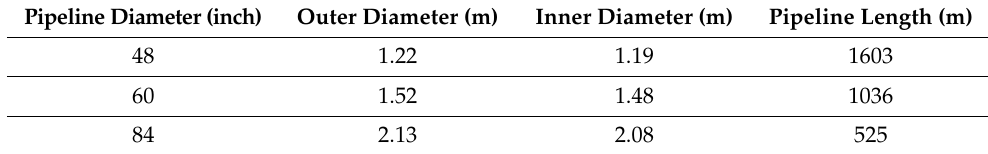
Table 3. Different accumulator pipeline dimensions considered, apart from the baseline